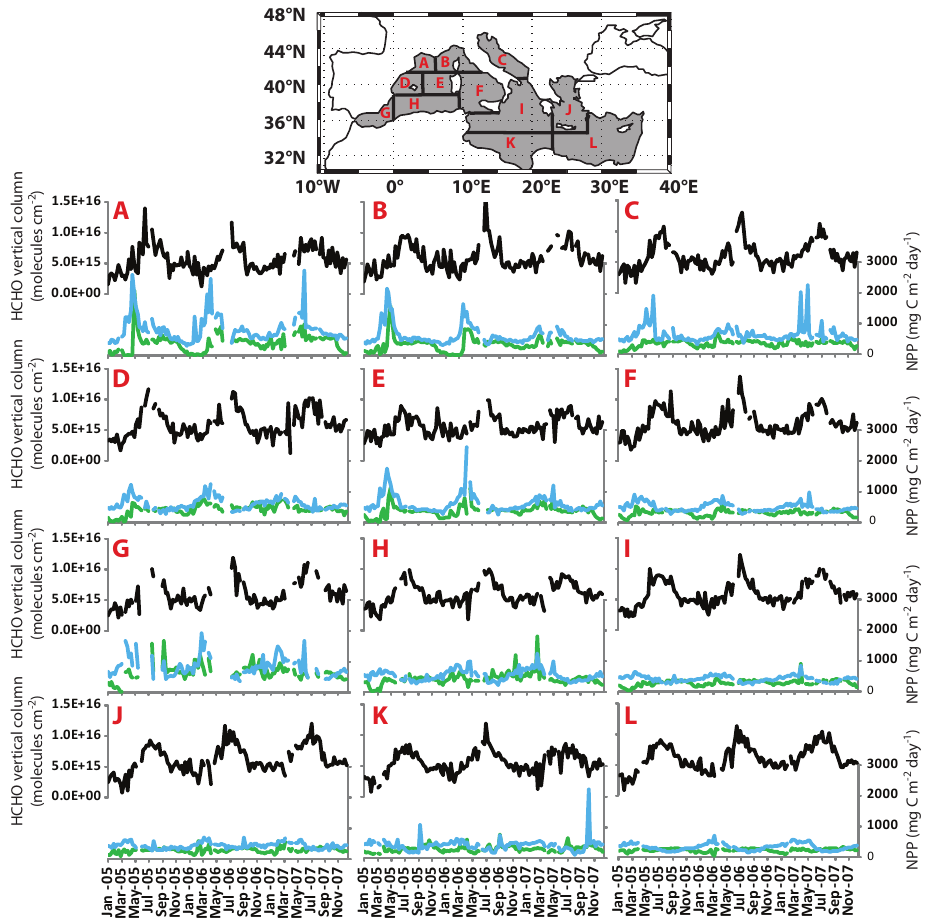
Fig. 5. Time series of 8-day averaged HCHO vertical columns from OMI (black) recalculated using corrected AMF values for January 2005 to December 2007 and the net primary productivity as estimated from the CbPM (green) and Vertically Generalized Production Model (VGPM) (blue) methods based on input from MODIS-Aqua and filtered to include only temporally and spatially collated 0 . 25 × 0 . 25 ◦ grids with 8-day averaged aerosol optical depth (AOD) < 0.2 (interpolated from 1 × 1 ◦ level 3 data at 550nm from the MODIS-Aqua satellite). The Bricaud et al. (2002) Mediterranean Sea subregions are the (A) Gulf of Lions, (B) Ligurian Sea, (C) Adriatic Sea, (D) Baleraric Sea, (E) Algeroprovencal Basin, (F) Tyrrhenian Sea, (G) Alboran Sea, (H) Algerian Basin, (I) North Ionian Sea, (J) Aegean Sea, (K) South Ionian Sea, and (L) Levantine